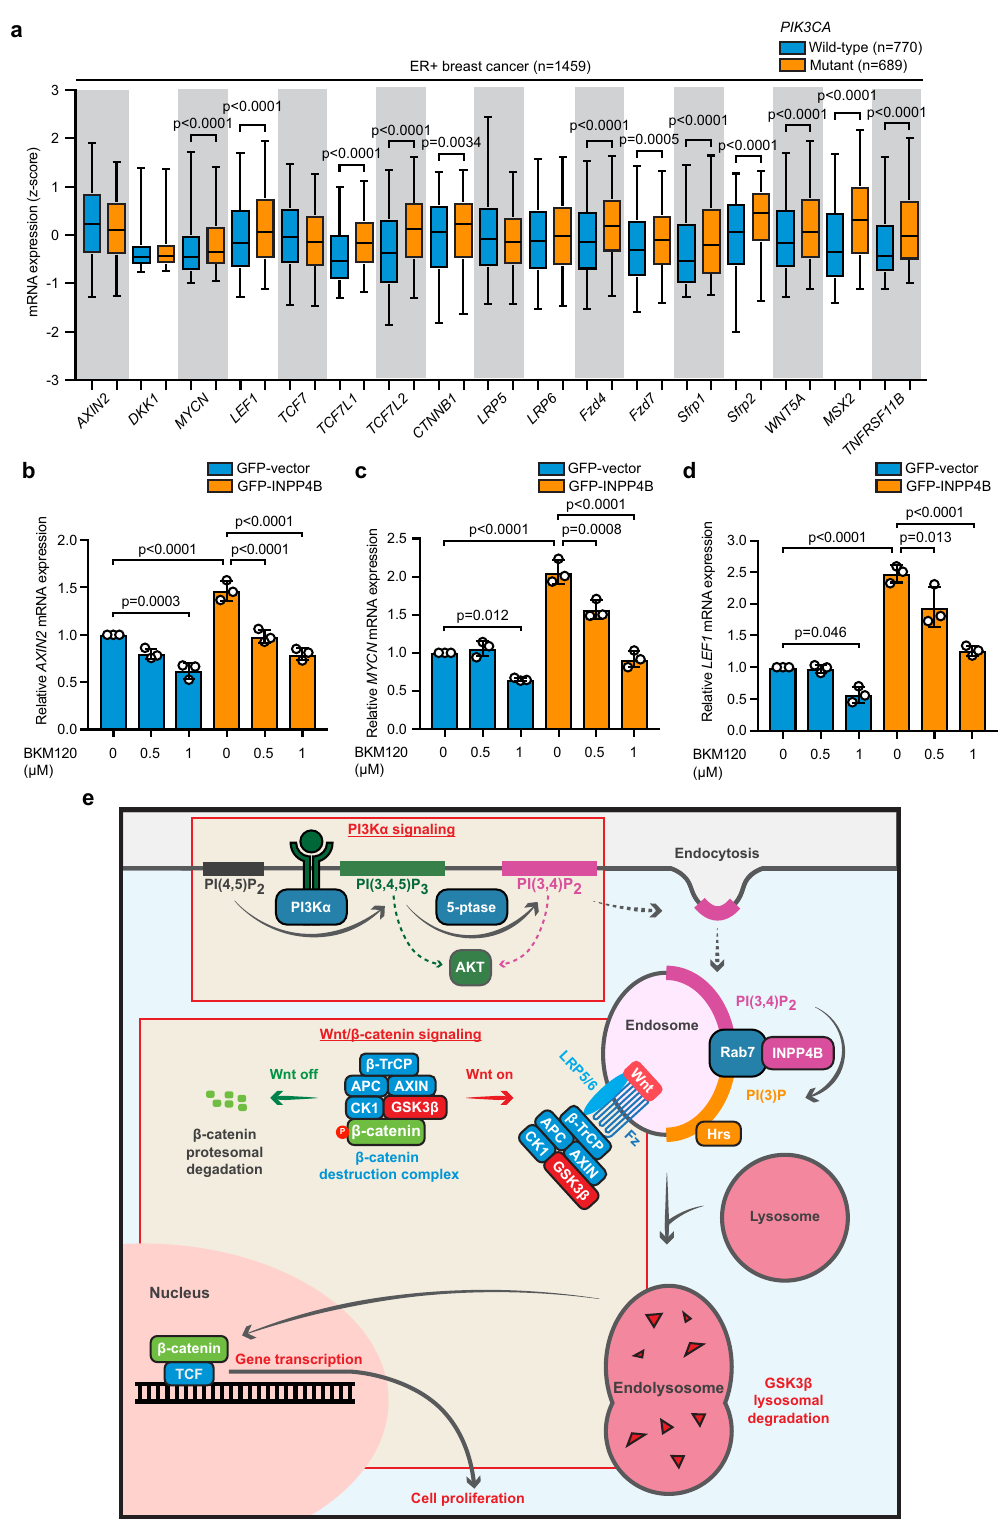
(Supplementary Table 1), which were a kind gift from Subbareddy Maddika 63 . pLVX-TRE3G-mCherry-Myc-INPP4B WT and pLVX-TRE3G-mCherry-Myc- INPP4B C842A lentiviral plasmids were generated by digesting pLVX-TRE3G- mCherry (Clontech, Cat # 631352) with Nde1 / Mlu1 . Myc-INPP4B WT or Myc- INPP4B C842A19 were ampli fi ed with with Nde1 / Mlu1 restriction sites, then digested and cloned into the Nde1 / Mlu1 site of pLVX-TRE3G-mCherry. All plasmid